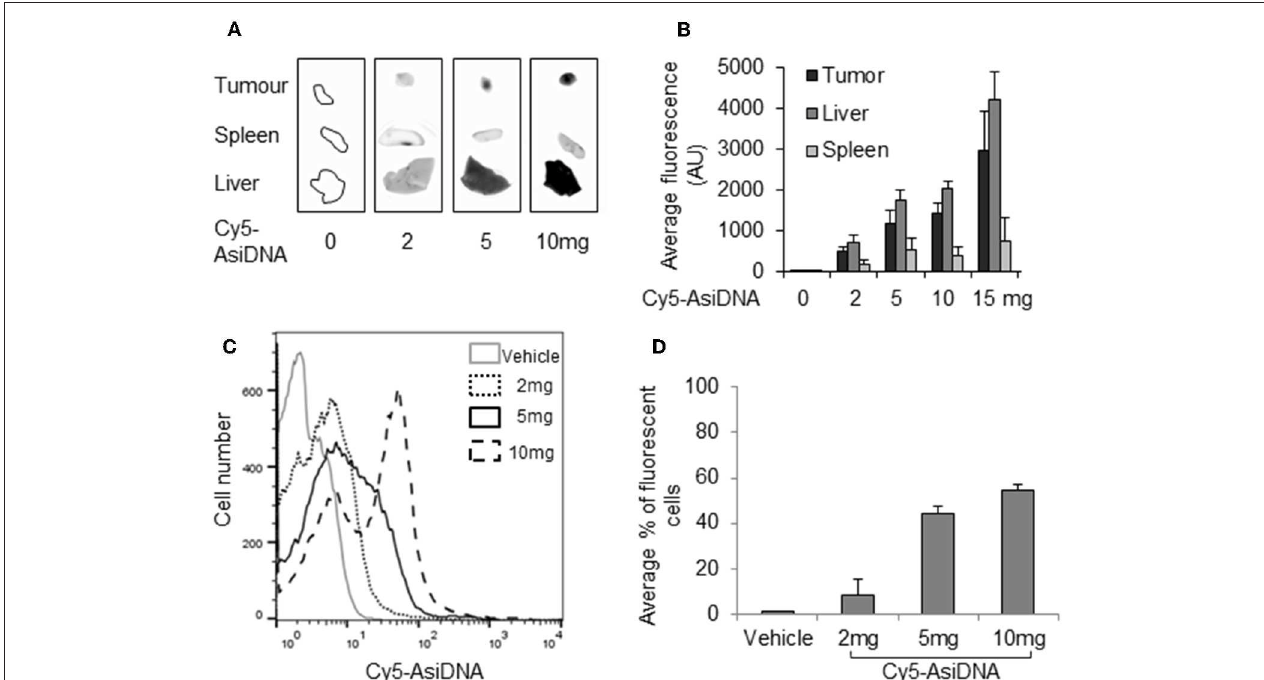
FIGURE 5 | Distribution of AsiDNA. Animals were injected with cy5-AsiDNA (0, 2, 5, 10, 15mg) and sacrificed 6h later, and fluorescence was monitored in organs: tumor, liver, and spleen: (A) characteristic pictures and (B) mean fluorescence quantification for six animals. (C,D) Bone marrow was sampled and analyzed by flow cytometry: (C) representative distribution of bone marrow cells of a mouse from each treatment group and (D) mean percentage of fluorescent bone